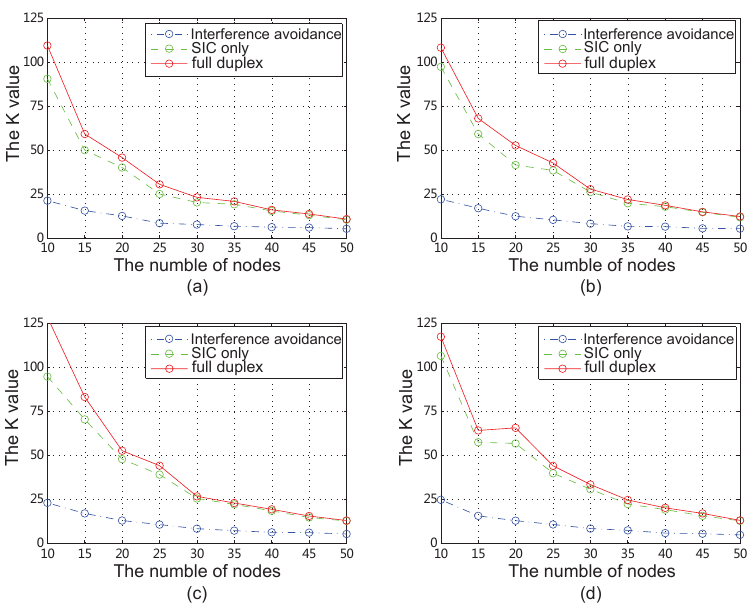
Figure 8. More comparisons for different number of nodes and base stations ( a ) 2 base stations. ( b ) 3 base stations. ( c ) 4 base stations. ( d ) 5 base